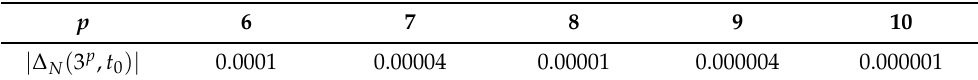
Table A2. Deviations in the uniform N = 3 p approximations for increasing p . Note that values higher than p = 10 could not be checked with the PC at